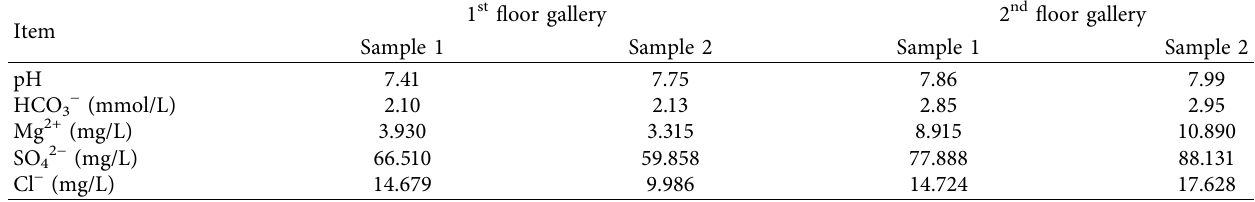
Table 2: Groundwater aggressivity in the drainage galleries near the tailrace surge chamber.